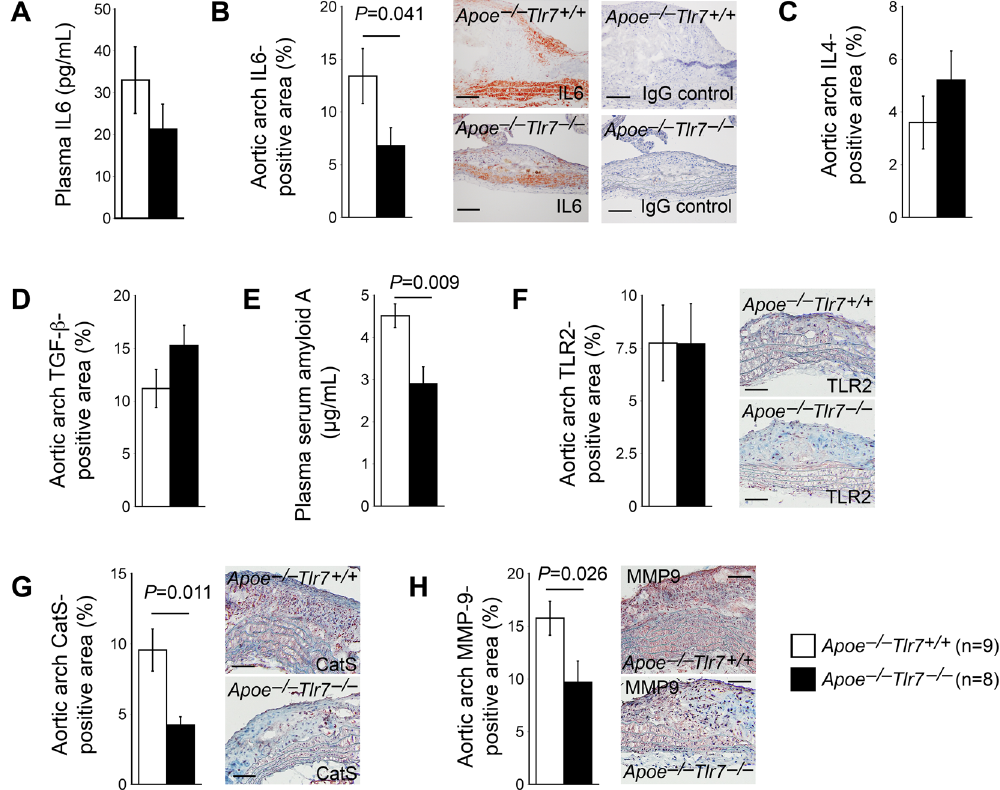
Figure 4. TLR7 deficiency changes aortic arch atherosclerotic lesion inflammatory cytokine and protease expression in male Apoe − / − mice. ( A ) Plasma IL6 level. ( B ) Lesion IL6-positive area percentage. Representative images are shown in the middle panels. Rabbit IgG isotype control staining results from parallel sections are show in the right panels. Scale: 200 µ m. ( C ) Lesion IL4-positive area percentage. ( D ) Lesion TGF- β -positive area percentage. ( E ) Plasma SAA level. Lesion TLR2-positive area ( F ), CatS-positive area ( G ), and MMP-9-positive area ( H ) percentages. Representative images are shown to the right panels. Scales: 100 µ m. Numbers and genotypes of mice are indicated in the